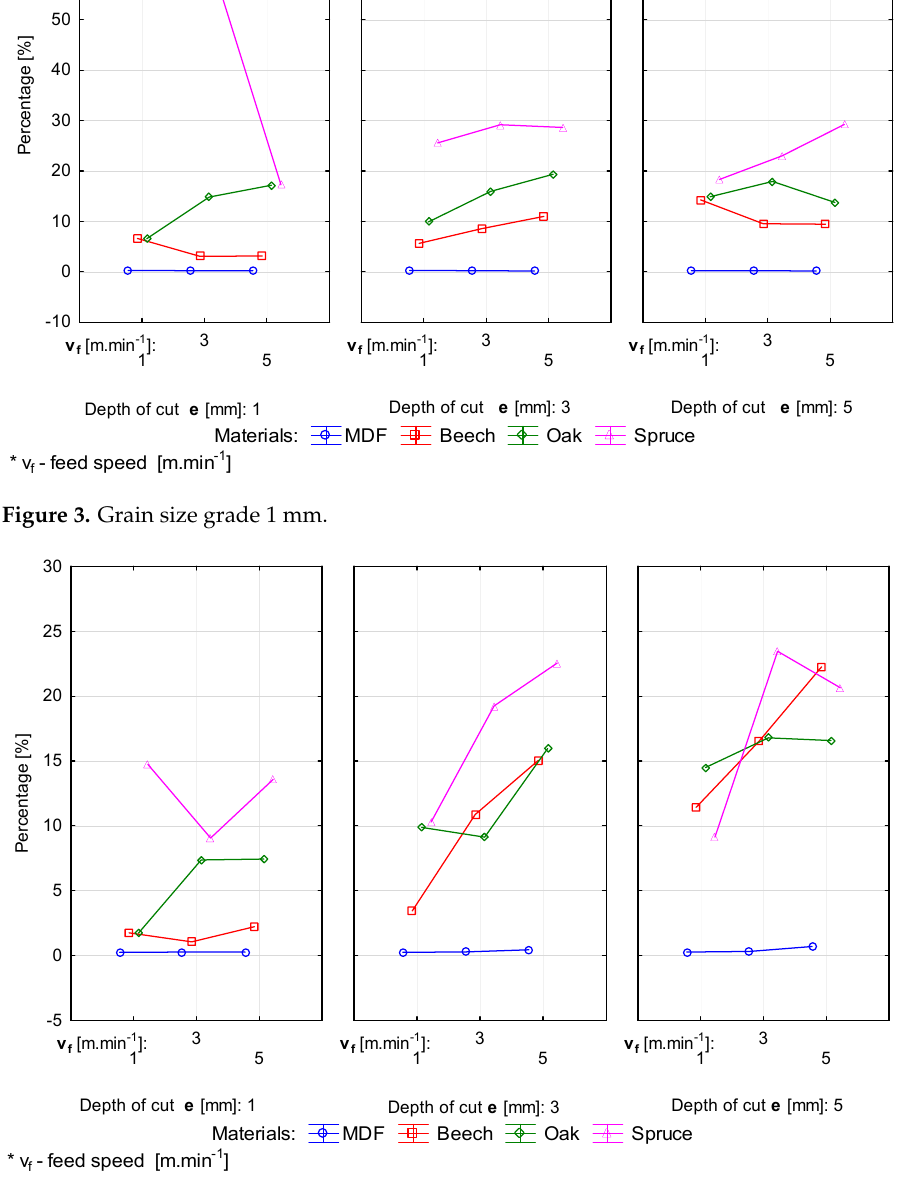
Figure 4. Grain size grade 500 μ m.